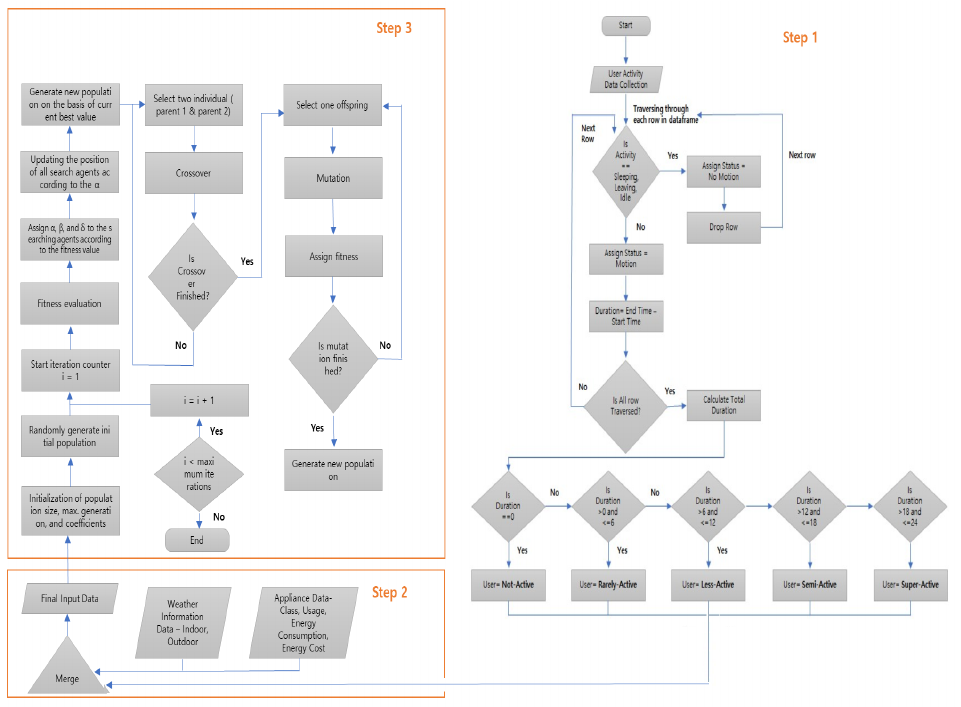
Figure 6. Flowchart of the scheduling algorithm.